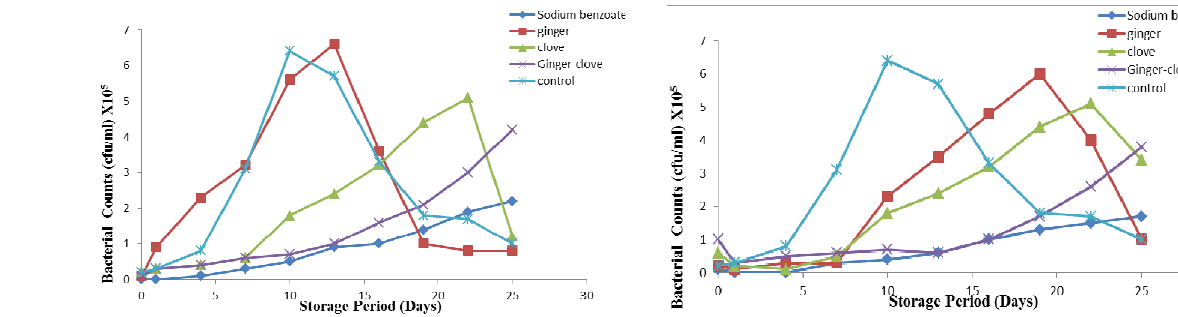
Fig. 1. Effects of different treatments on bacterial counts of soymilk samples at 1% concentration stored at refrigerated temperature for 25 days